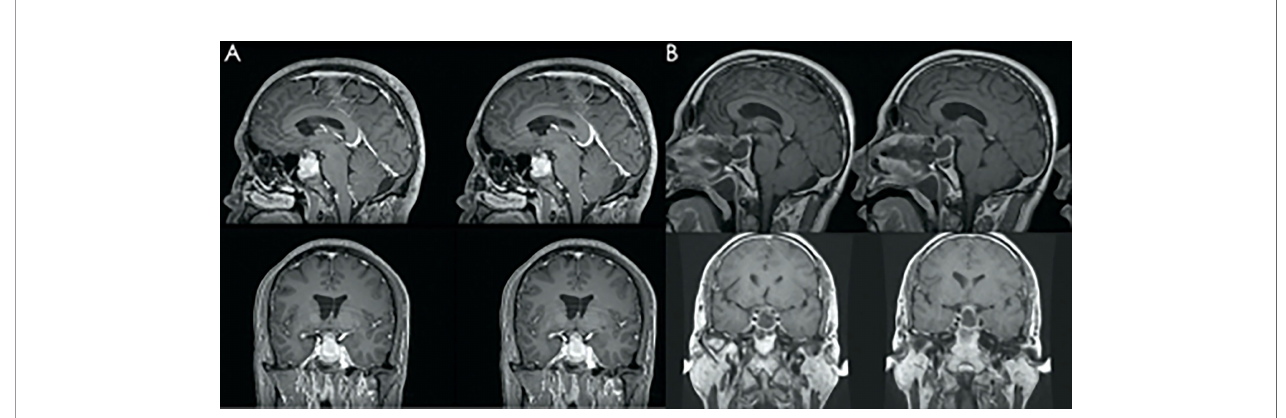
FIGURE 2 | Representative image of preoperative magnetic resonance imaging (MRI) (A) and postoperative MRI follow-up (B) . The MRI shows gross total resection of the tumor.